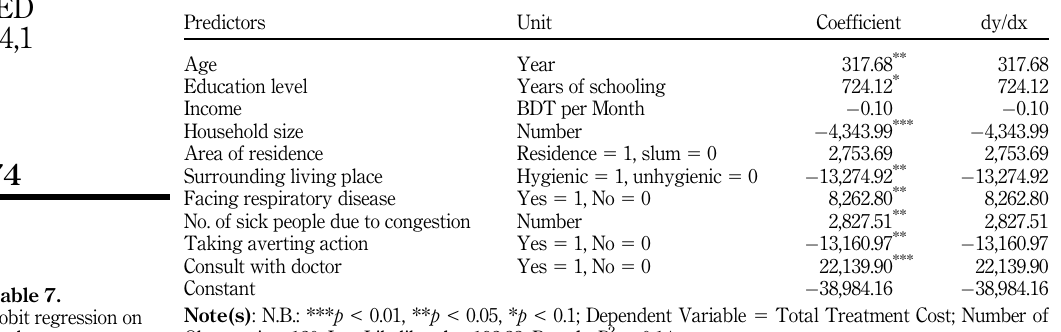
Table 7. Tobit regression on total treatment cost